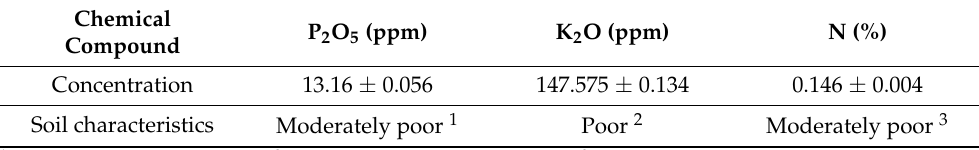
Table 2. Selected chemical characteristics of the used